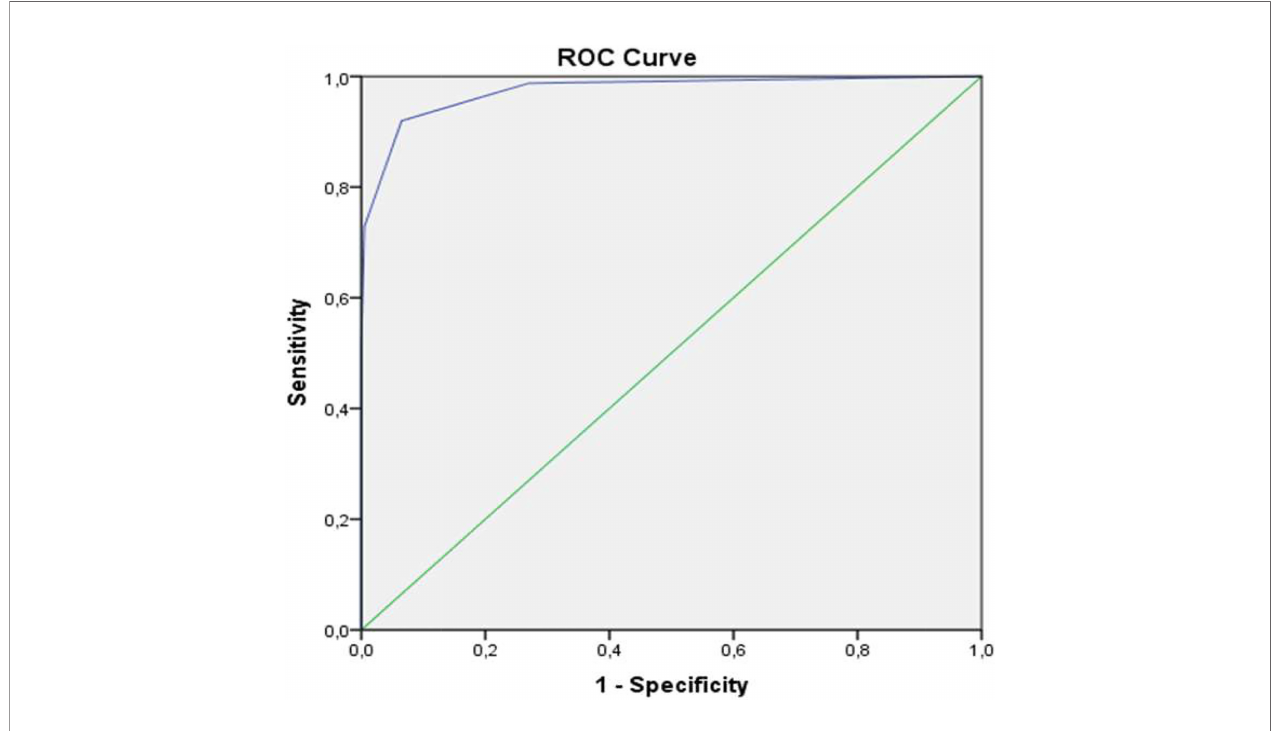
FIGURE 1 | The ROC curve for JMF score in the PID and SID groups.